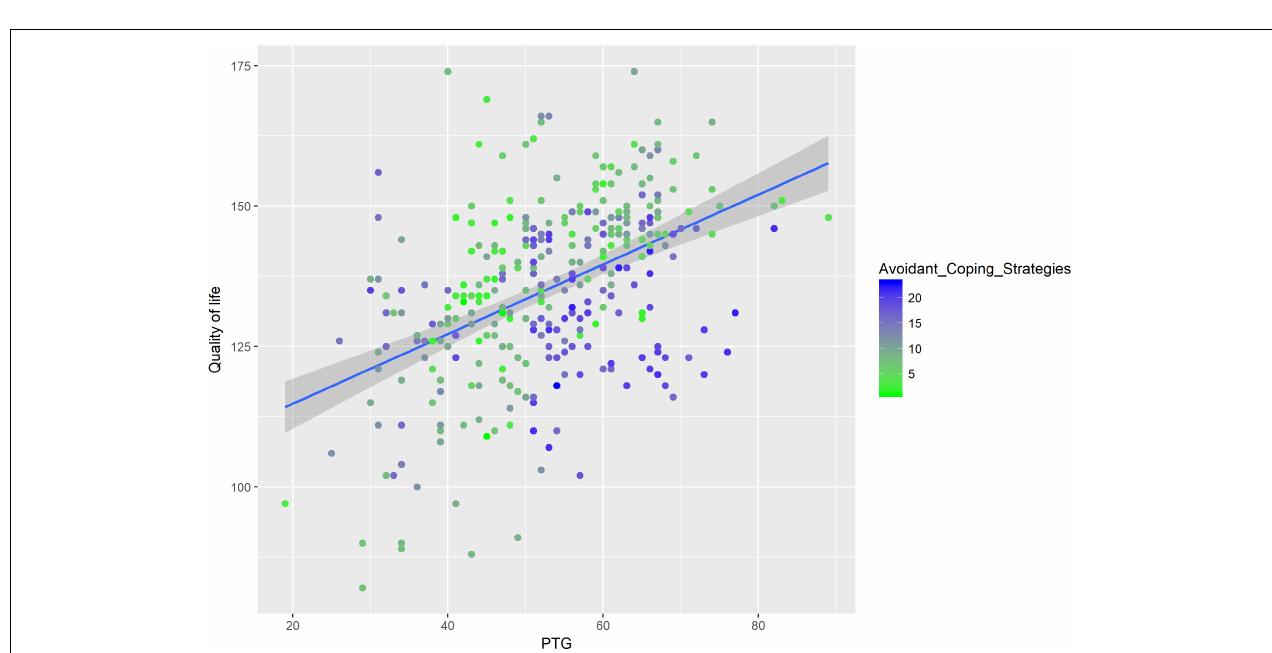
FIGURE 5 | The moderating effect of avoidant coping on the relationship between PTG and QoL.